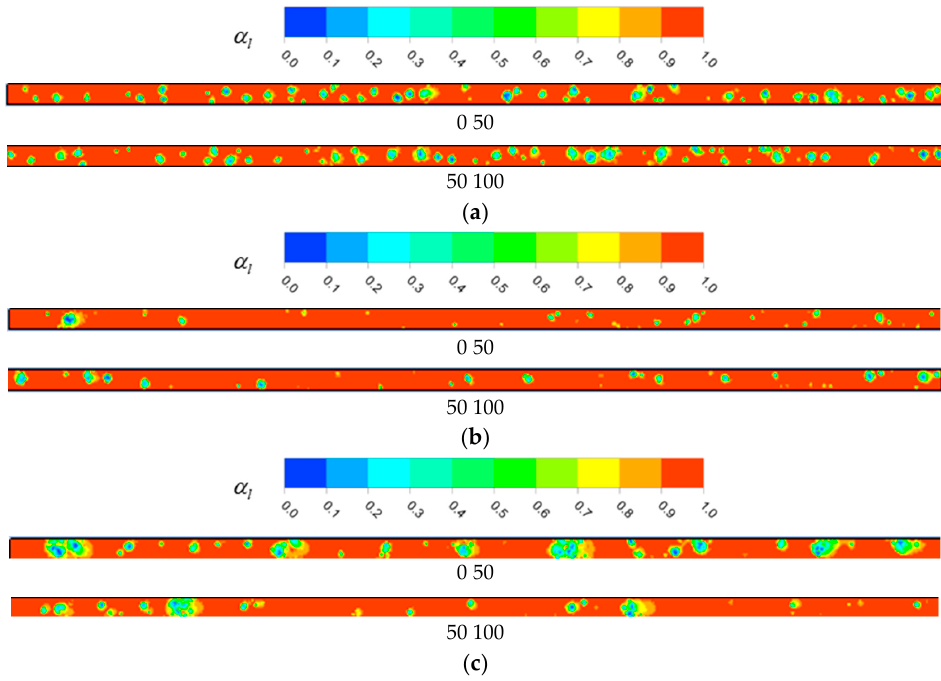
Figure 6. Volume fraction distribution of R744 liquid phase at different T sat values: ( a ) T sat = 253 K, G = 50 kg/m 2 · s, q = 10 kW, X = 0.28; ( b ) T sat = 263 K, G = 50 kg/m 2 · s, q = 10 kW, X = 0.31; ( c ) T sat = 273 K, G = 50 kg/m 2 · s, q = 10 kW, X = 0.35.